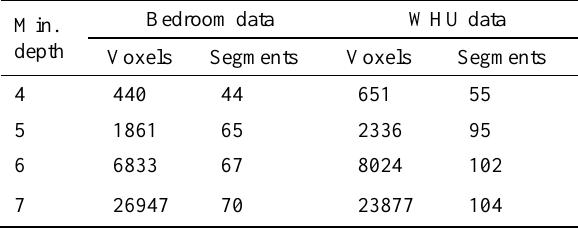
Table 2. The effect of the minimal octree depth threshold on the super voxel number and the segmentation number.